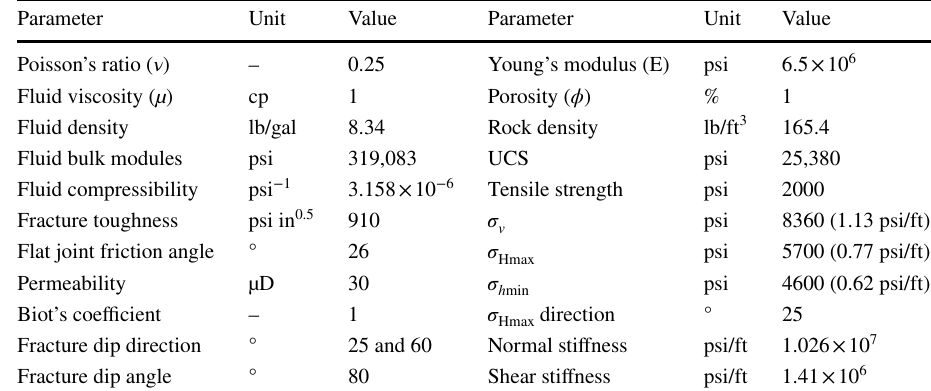
Fig. 6 A G-function plot for Cycle #2. It is difficult to pick the closure using the GdP/ dG plot. Two possible closure points: point 1 (shut-in = clo- sure) and point